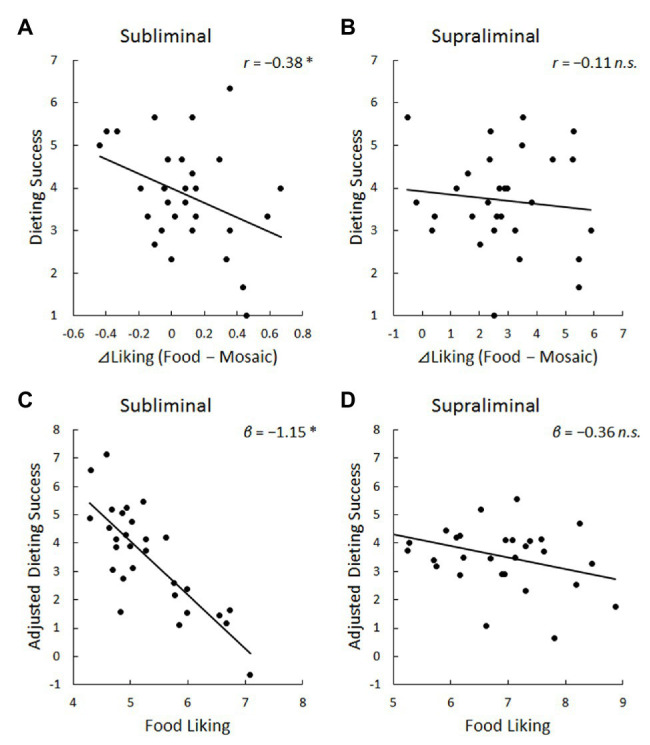
Scatter plots and regression lines for the relationship of dieting success scores (or their adjusted values) with liking difference scores (i.e., food–mosaic) under the subliminal (A) and supraliminal (B) presentation conditions and food liking scores under the subliminal (C) and supraliminal (D) presentation conditions. Dieting success was assessed using the perceived self-regulatory success in dieting scale (PSRS). Adjusted values were derived by partialing-out the effects of no interest (i.e., liking scores for mosaics and squared and product terms for liking scores for food and mosaics). Liking scores under the food condition (food liking) were assessed indirectly (for target ideographs after food primes) under the subliminal condition and directly (for food images) under the supraliminal condition. *
p < 0.05; n.s. = not significant.